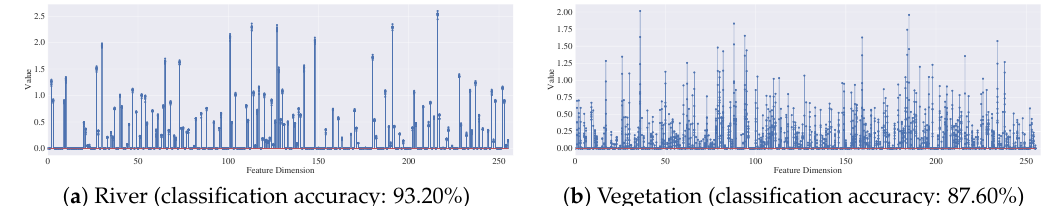
Figure 20. Feature visualization. Here, ten samples are randomly selected from the River ( a ) and the Vegetation ( b ) in Guangdong dataset. The feature vectors extracted by PSNet for these samples are